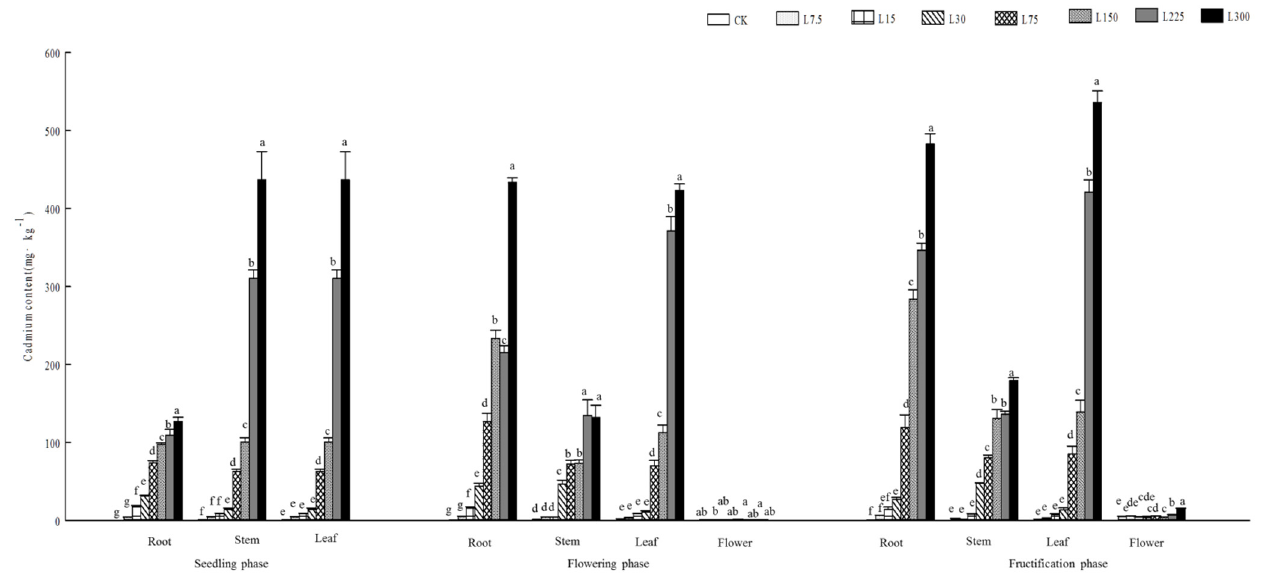
Figure 4. Effect of Cd stress on Cd distribution in Tagetes patula . The leaf for the measurement of Cd was sampled on days 30 (seedling phase), 79 (flowering phase) and 122 (fructification phase) after transplantation. Each bar denotes the mean of 3 replicates, with standard error based on means (MSE). Different letters indicate significant differences among Cd concentrations within the same growth stage and organ compared by Fisher’s least significant differences (LSD) test at p ≤ 0.05.